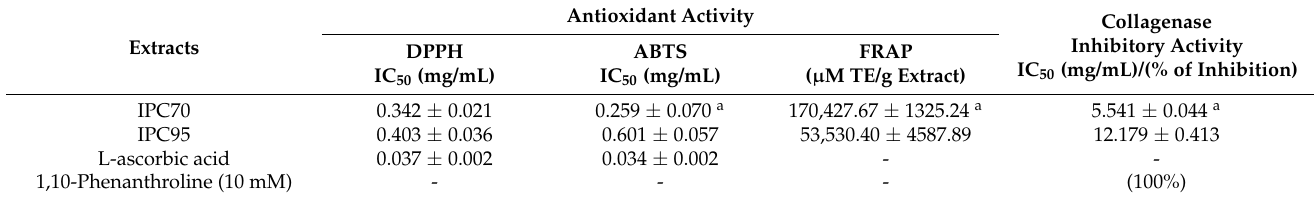
Table 2. Antioxidant and collagenase inhibitory activities of IPC